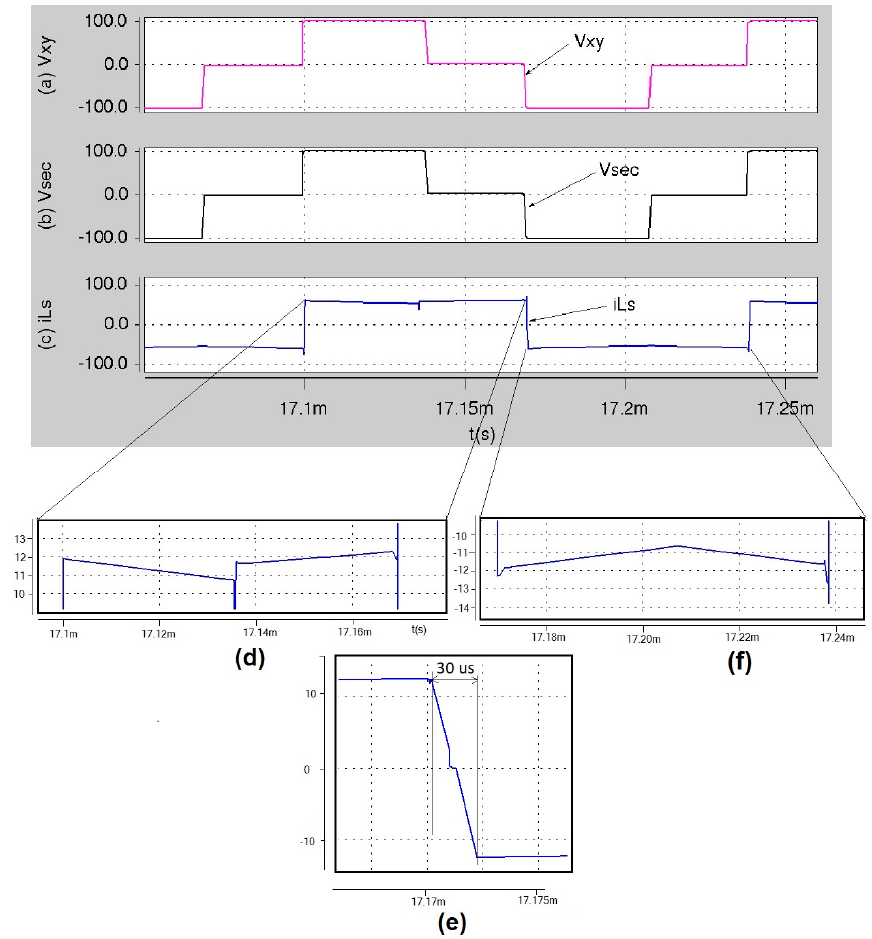
Figure 19. Simulation results: ( a ) voltage v xy ; ( b ) v sec ; ( c ) current i Ls ; ( d ) Expanded portion of the first semicycle; ( e ) expanded portion of T ovL ; and ( f ) expanded portion of the second semicycle. Supply: 127 V, 60 Hz, Output: 100 V, 5 kW.